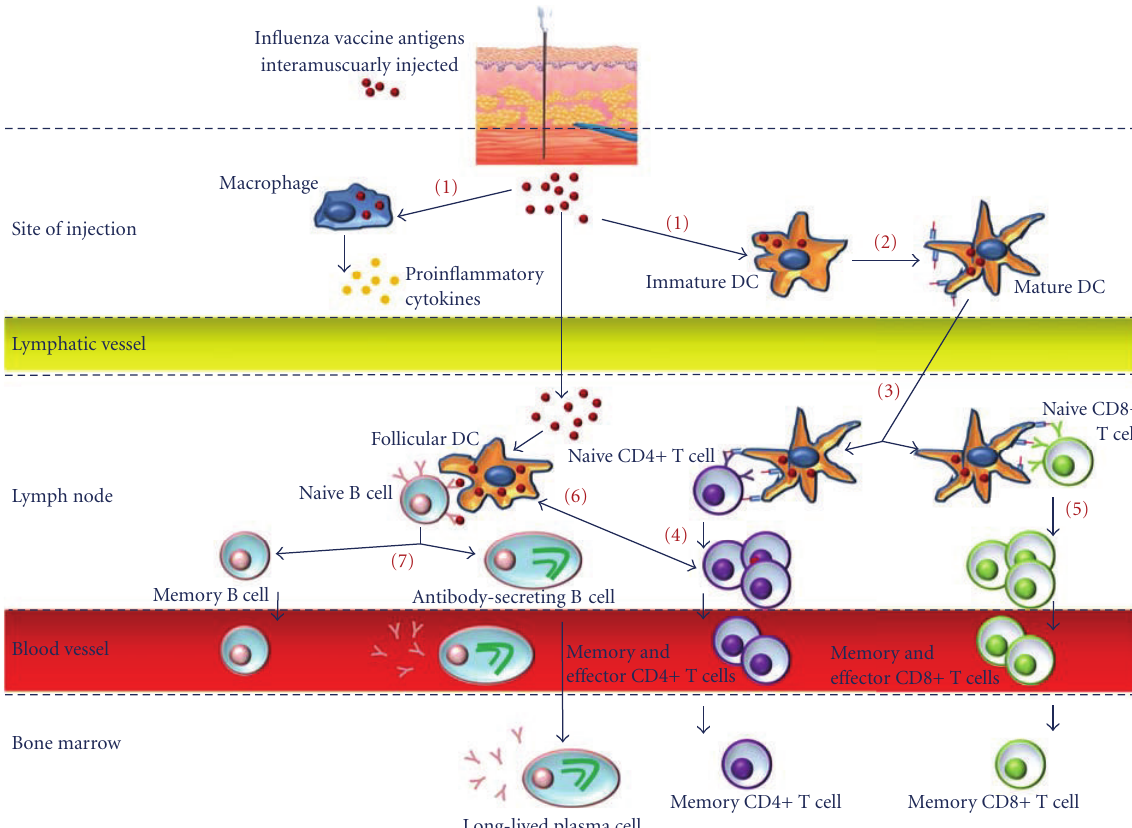
Figure 2: The normal immune response following influenza vaccination. Administration of vaccine antigens induces the activation of the innate immune responses at the site of injection. The antigen is taken up by antigen-presenting cells (1), such as macrophages and dendritic cells (DCs). The local innate immune response facilitates maturation of DCs, which present stable major histocompatibility complex/peptide complexes (2). Mature DCs migrate into lymph nodes (3), where they induce activation and clonal expansion of naive CD4+ (4) and CD8+ (5) T cells. The activation and di ff erentiation of naive B cells is induced by antigen and CD4+ T helper cells (6). Naive B cells di ff erentiate into memory B cells and antibody-secreting B cells (7). Long-term immunity is assured by memory B and T cells in the blood and lymph nodes, as well as by long-lived plasma cells and memory T cells in the bone marrow (adapted from